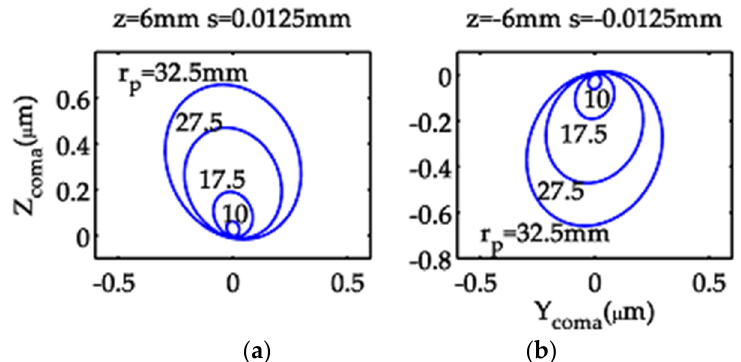
Figure 3. Coma curves of the model optical system in the meridional focal plane, illustrating changes in pattern with r p , for settings ( a ) z = 6 mm and s = 0.0125 mm and ( b ) z = − 6 mm and s = − 0.0125 mm.